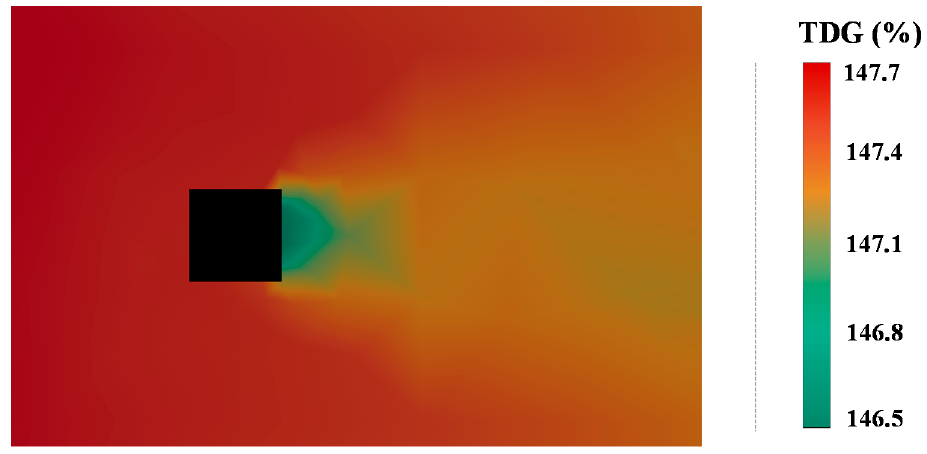
Figure 11. The distribution of supersaturated TDG around a single column (Z = 0.09 m).